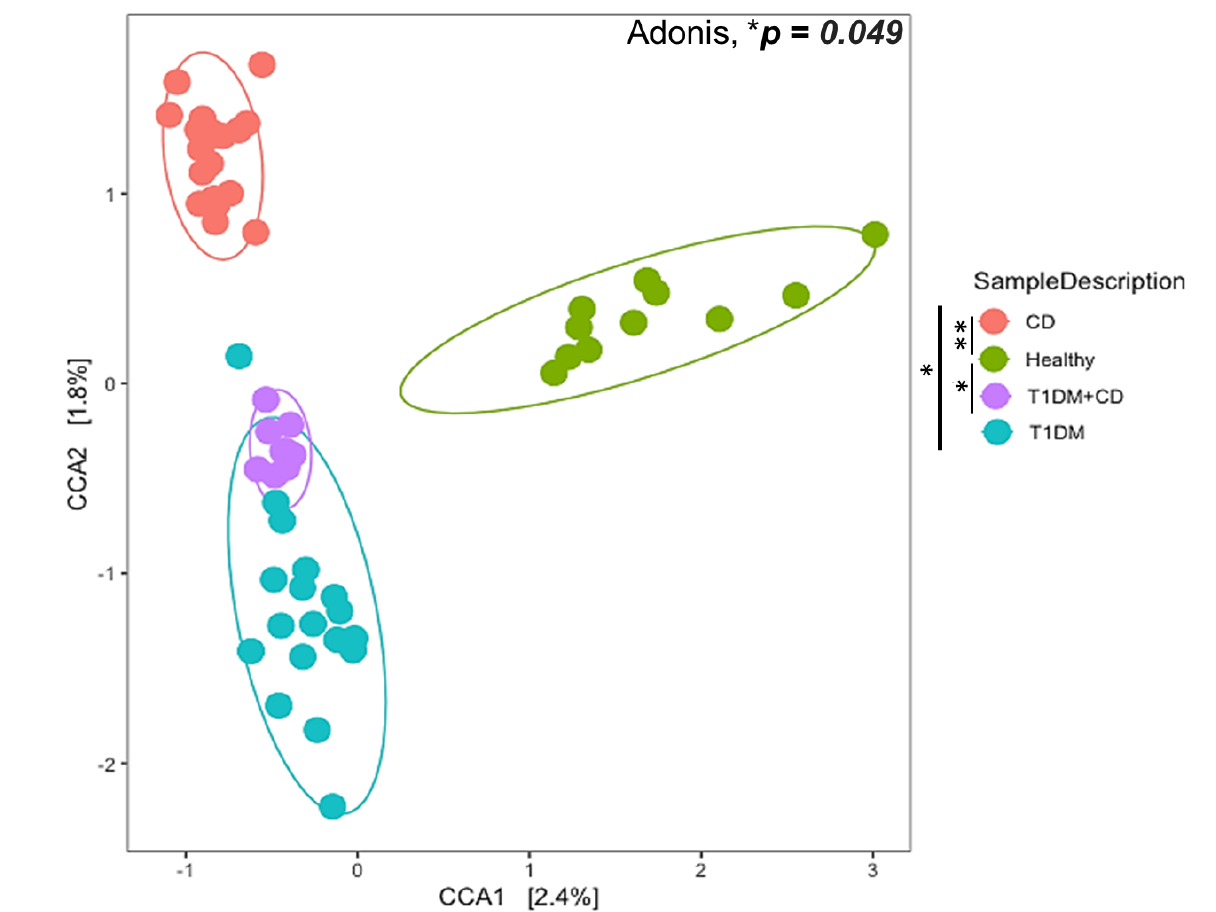
Figure 1. Ordination plot of Canonical Correlation Analysis (CCA) to explore between the sample diversity (Beta diversity). Samples from different groups: CD (orange), T1DM (blue), healthy control (green), T1DM+CD (purple) had a significant overall difference in composition (Adonis * p = 0.049). The difference observed was statistically significant between patients with CD or T1DM+CD compared to healthy controls (** p = 0.006 and * p = 0.03 respectively). Abbreviations: T1DM = Type 1 Diabetes; CD = Coeliac disease; CCA = Canonical Correlation Analysis.